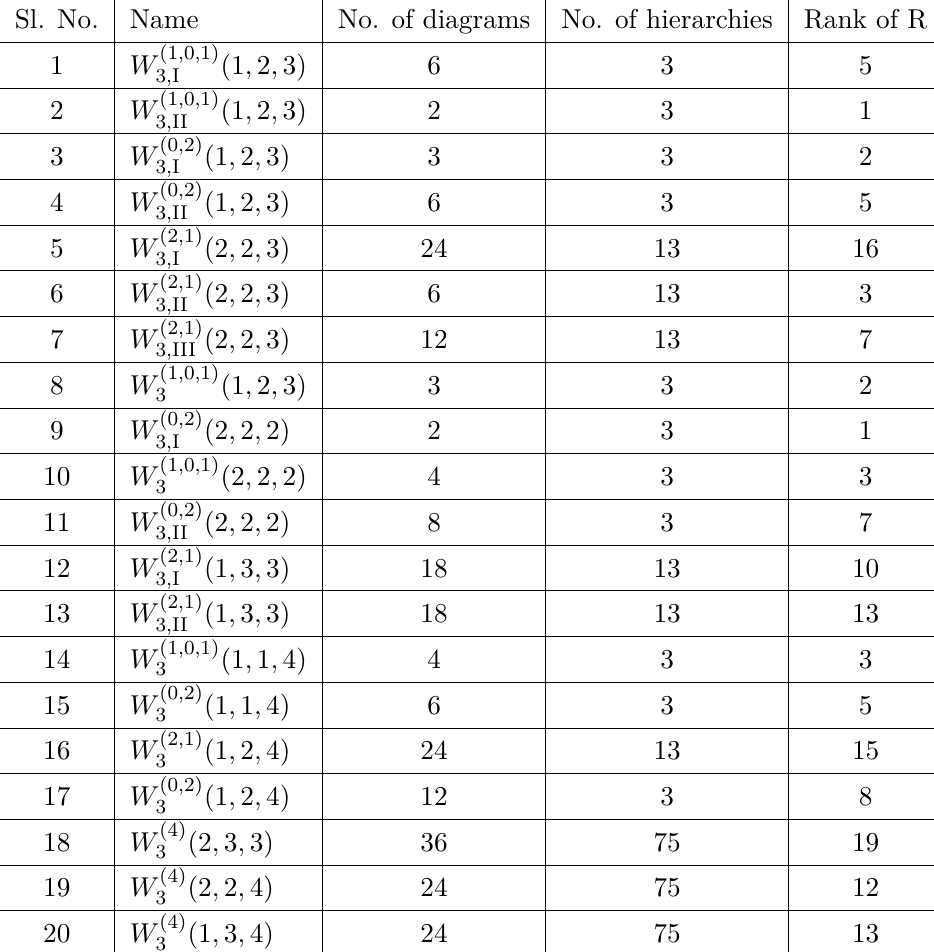
Table 3. Summary of the results for four-loop Cwebs connecting three Wilson lines.